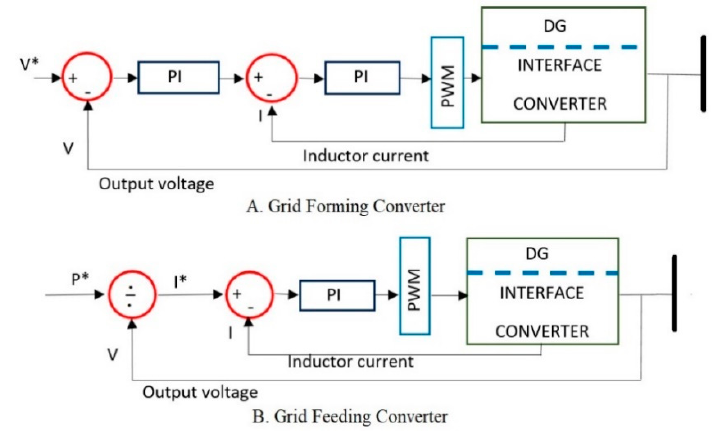
Figure 2. Control loops for grid-forming and grid-feeding converters [49].